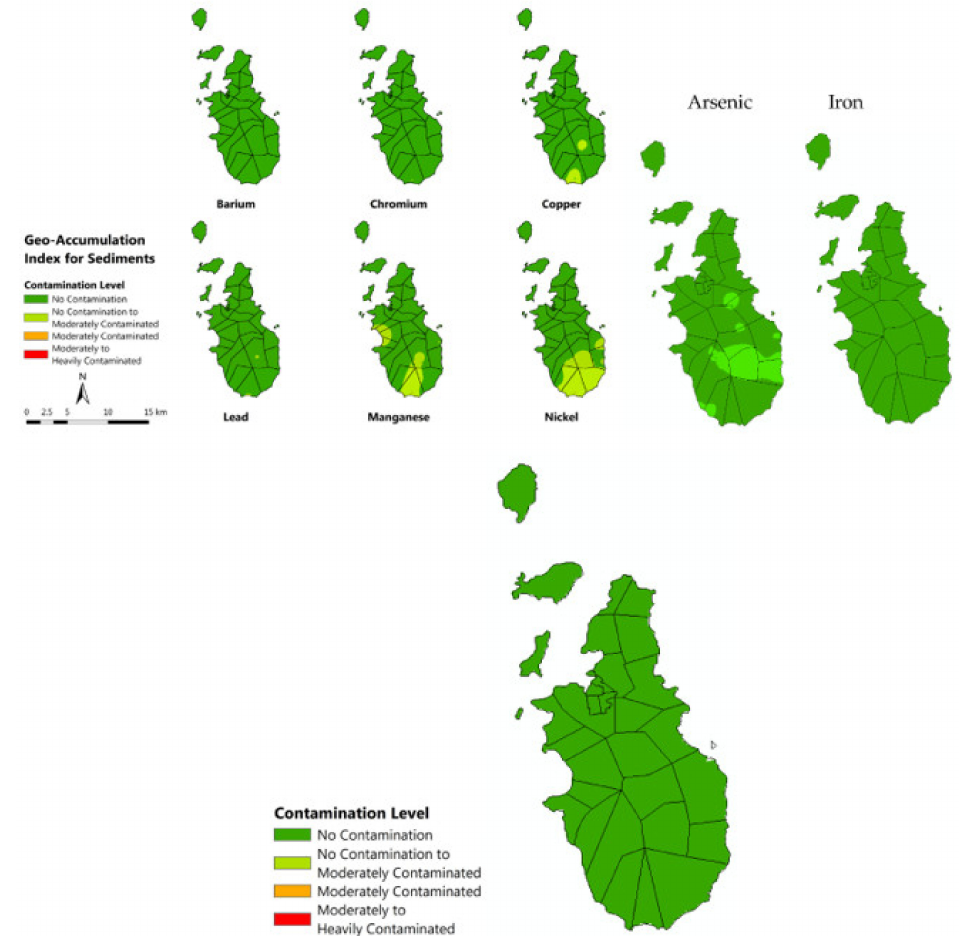
Figure 8. Geo-accumulation index of sediments for Ba, Cr, Cu, Pb, Mn, Ni, As, Fe, and